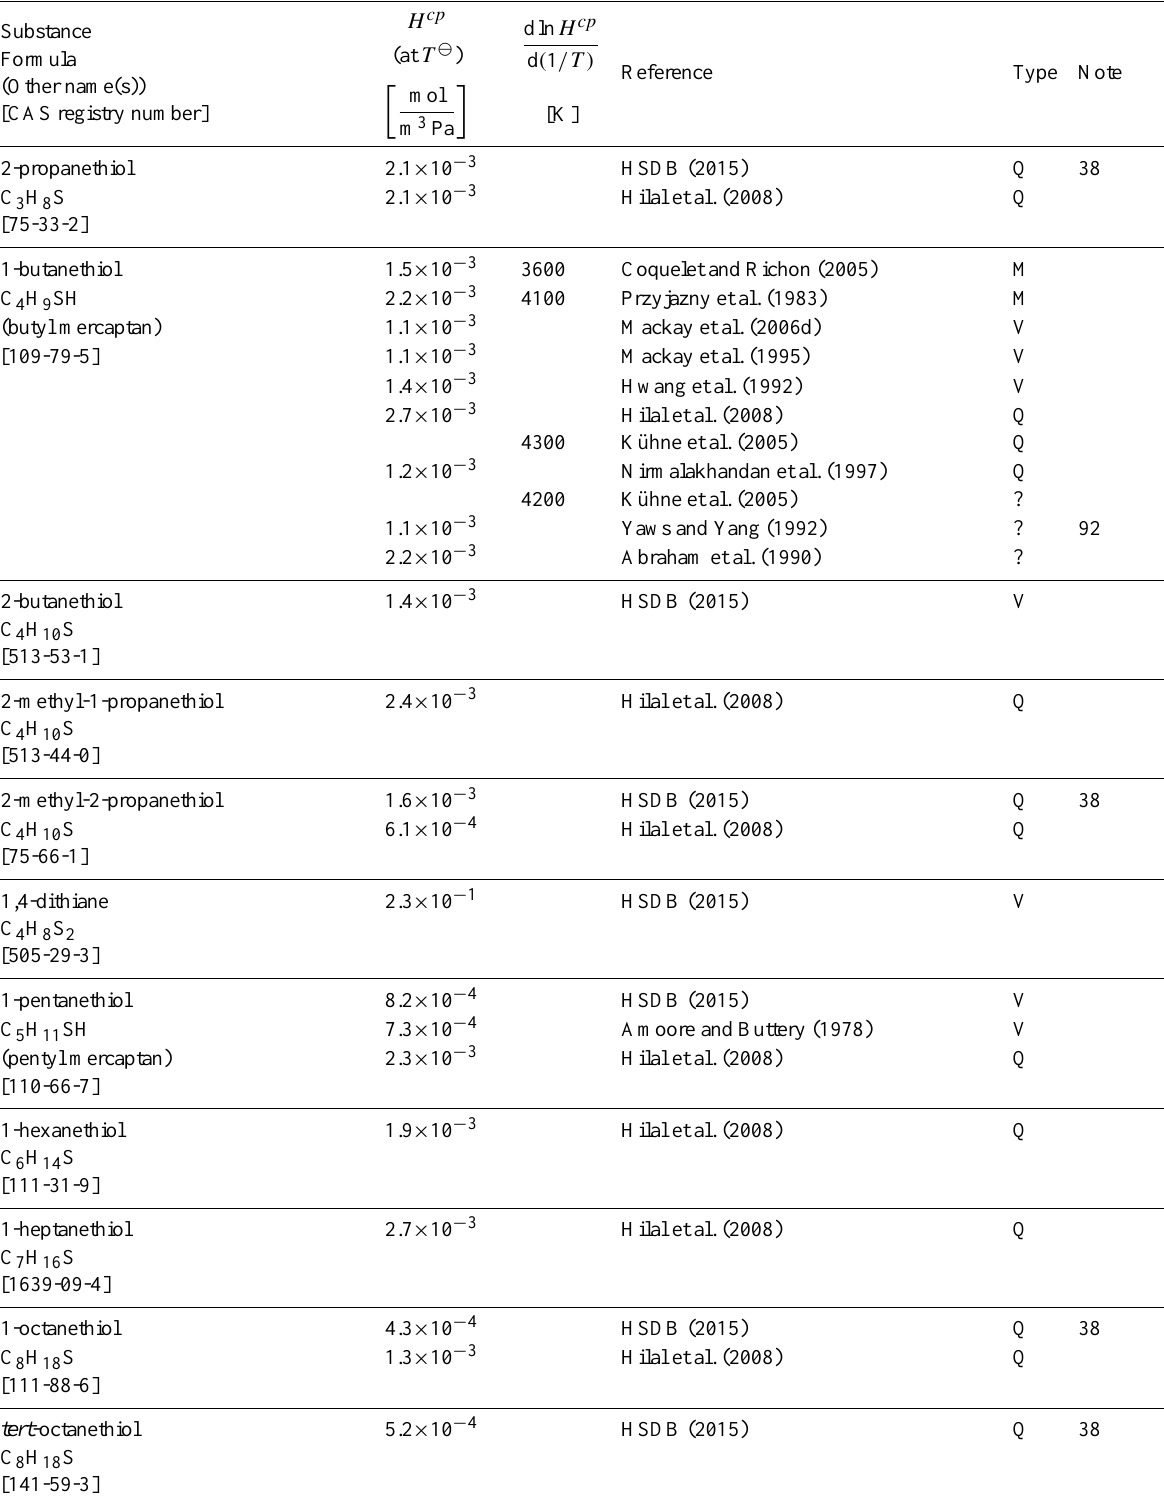
Table 6: Henry’s law constants for water as solvent